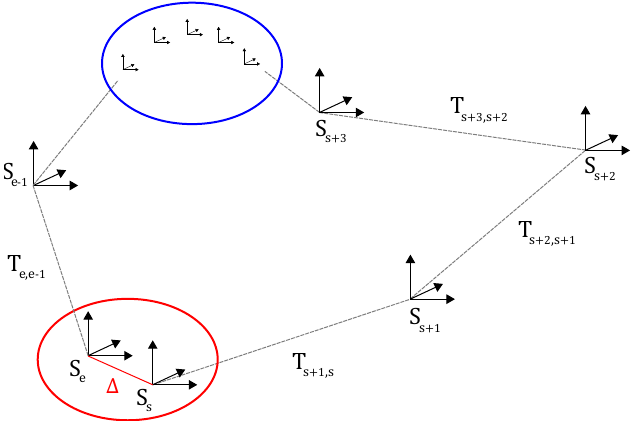
Figure 11. Overview of the loop closure procedure. When a loop has been detected, its loop transform ∆ is considered as an error and is propagated back in the pose graph. To this end, we use the residual of the minimization step (cf. Section 4.3) to assign a weight to each link in the pose graph. We assign a higher weight for those transformations that had a high residual in the previous minimization step. The idea is that a high residual indicates that two consecutive point clouds were potentially inaccurately